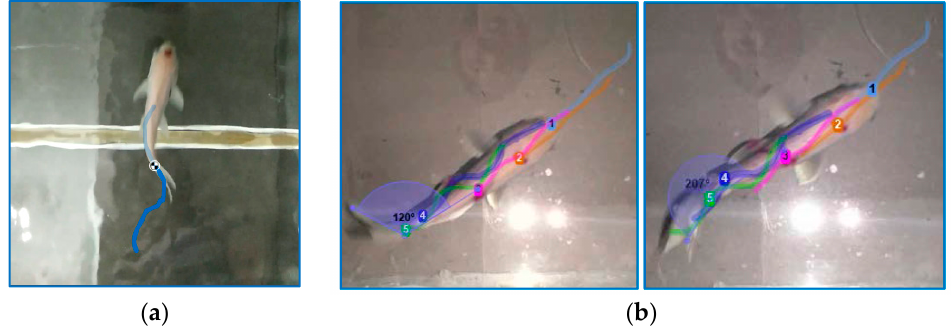
Figure 4. One period of the tail: ( a ) Trace of the travelling wave for 350 ms; ( b ) Caudal fin angles for forward swimming pattern: θ 5 = [ π − 0.6 π , π − 1.15 π ] .